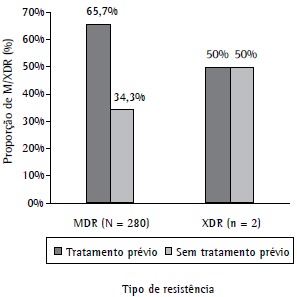
Proporção de casos com tuberculose multirresistente (MDR) e
extensivamente resistente (XDR) de acordo com a história de tratamento
antituberculose.